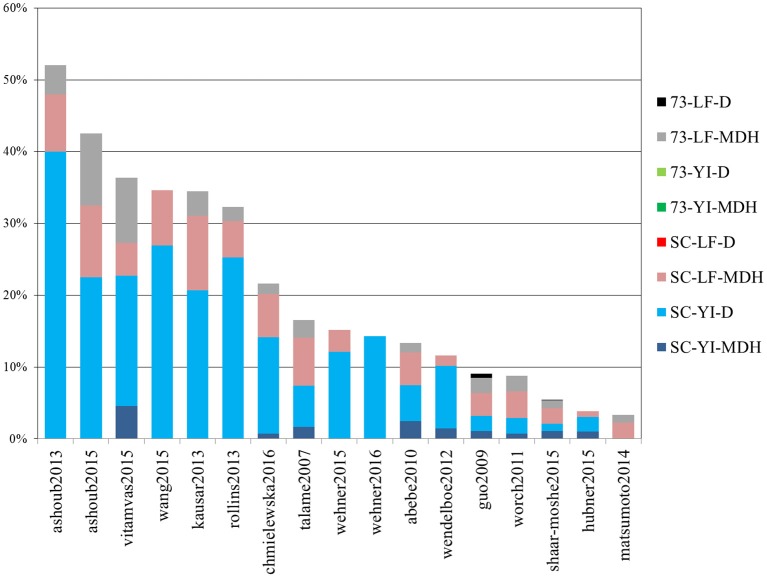
Percentage of differentially expressed tags from other studies which were identified in the present work. Bars indicate the percentage of differentially expressed tags (proteins, genes or isoforms) from other studies which were identified in this work. Each color represents the contribution of each contrast. The list of studies used for comparison is given in Table 4.